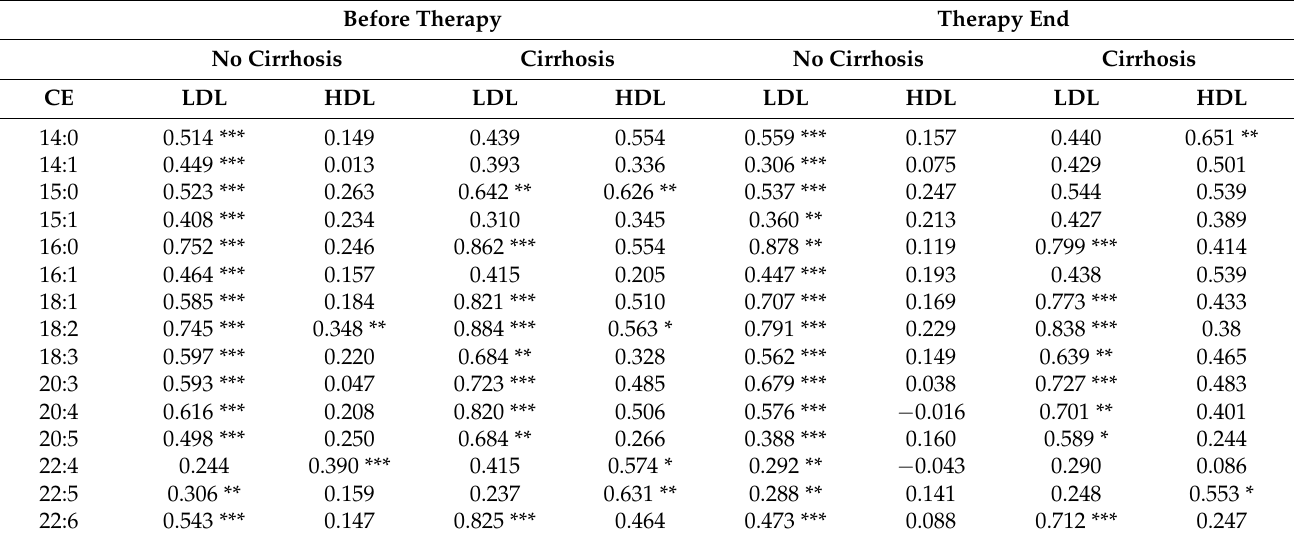
Table 5. Spearman correlation coefficients for the association of CE species with LDL and HDL before therapy and at therapy end in patients with and without ultrasound-diagnosed liver